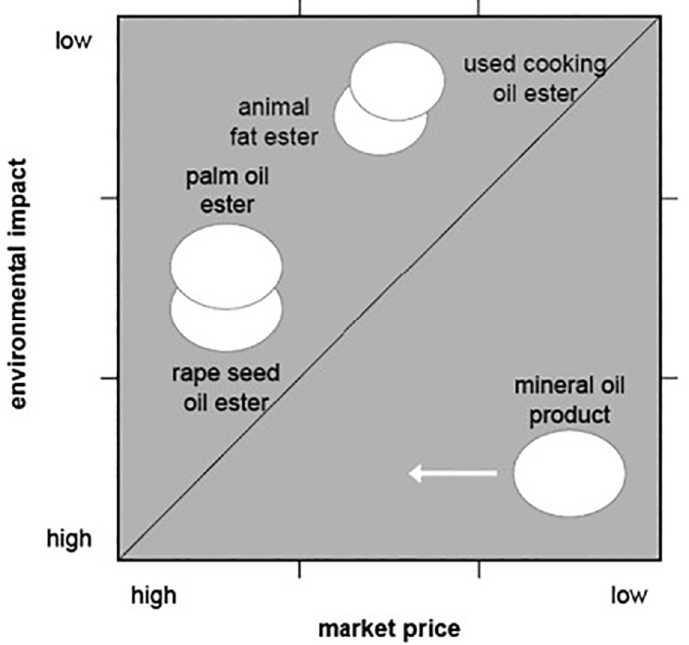
Figure 5. The economic and environmental impact of vegetable oil-based MWFs and mineral oil- based MWFs [51].